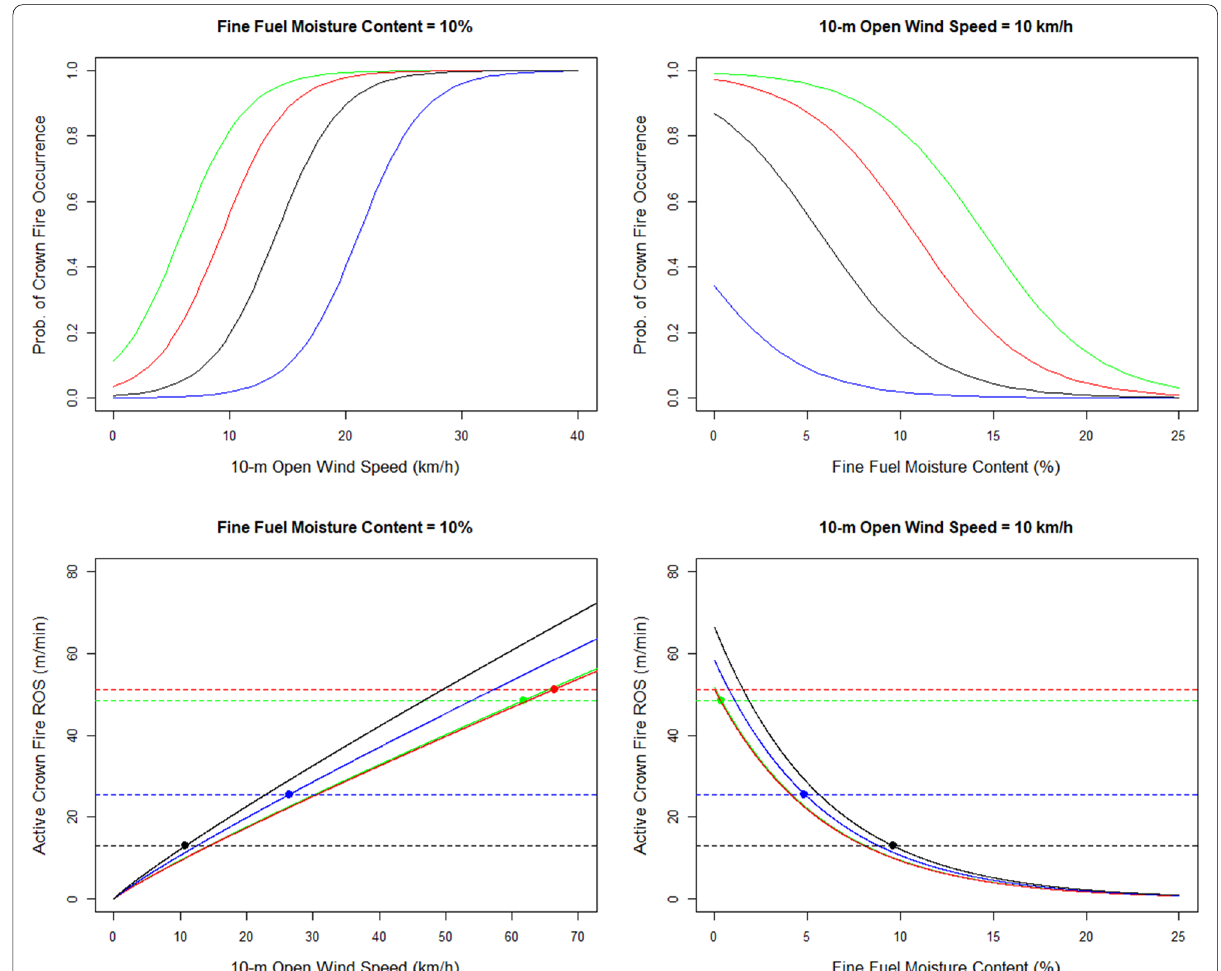
Fig. 3 Probability of crown fire occurrence and active crown fire rate of spread (ROS) by fuel class cluster (FCC) shown for combinations of 10-m open wind speed and fine fuel moisture content. Horizontal lines denote the minimum ROS for sustained propagation of a crown fire. Points denote the intersection of active crown fire ROS with the minimum ROS for sustained propagation of a crown